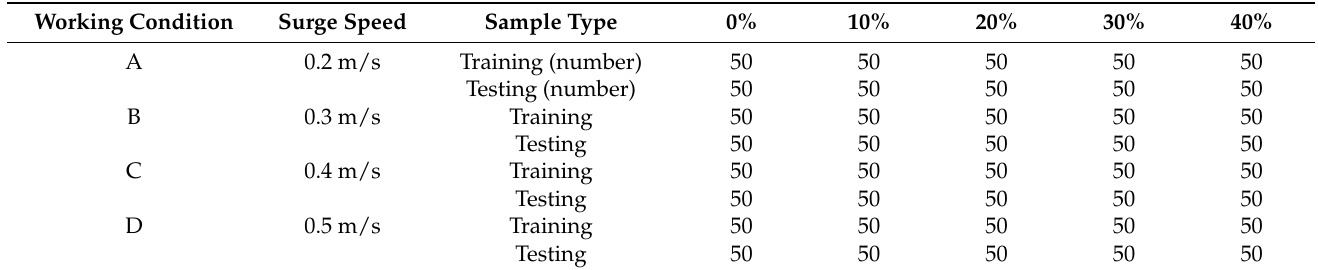
Table 1. Fault sample construction in